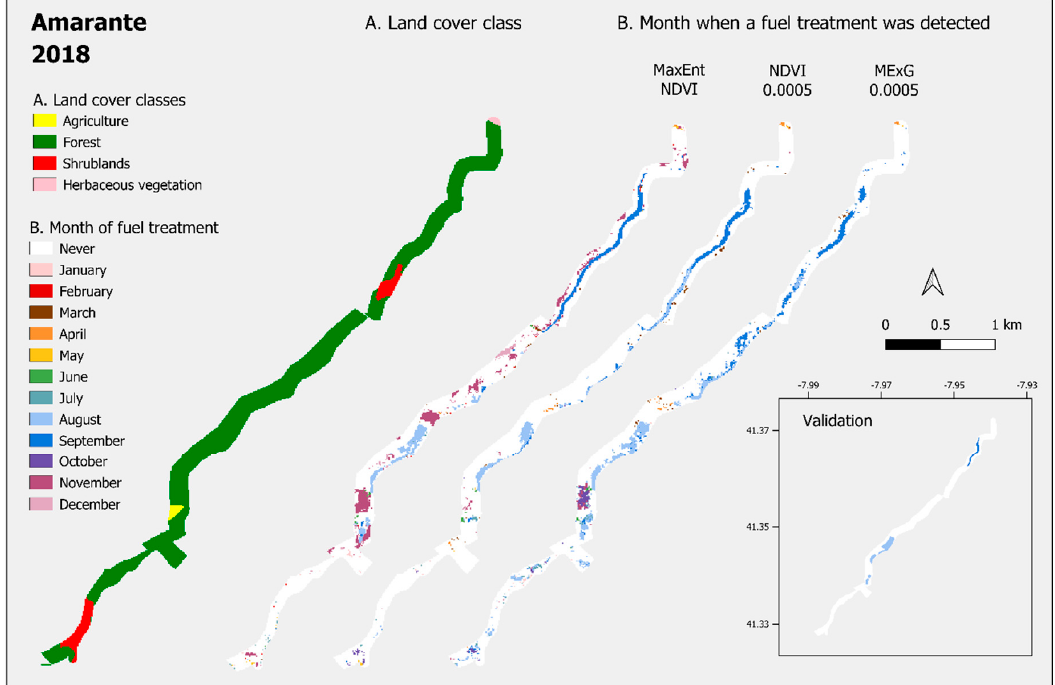
Figure 8. Results in a pine forest area in Amarante municipality in 2018: A. land cover; B. results of Method 1, MaxEnt NDVI classification, and Method 2, NDVI and MExG statistical detection with α = 0.0005.